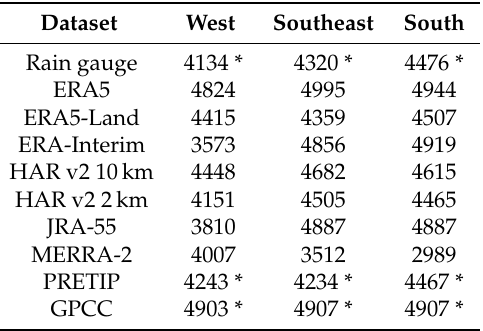
Table 2. Modeled elevation ( m a.s.l) of used grid cell.